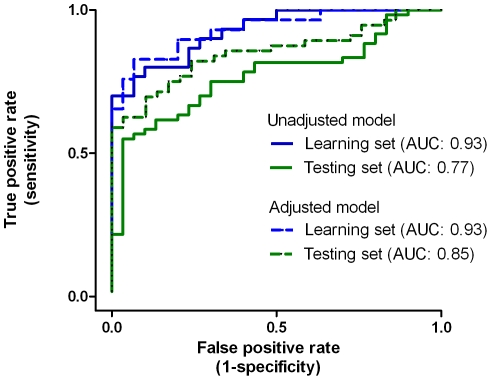
The area under the receiver operative characteristics curve of the seven-miRNA signature in the learning (in blue color) and testing (in green color) sets, respectively, without (in solid line) or with (in dotted line) adjustment for age, gender, education, and tobacco smoking.